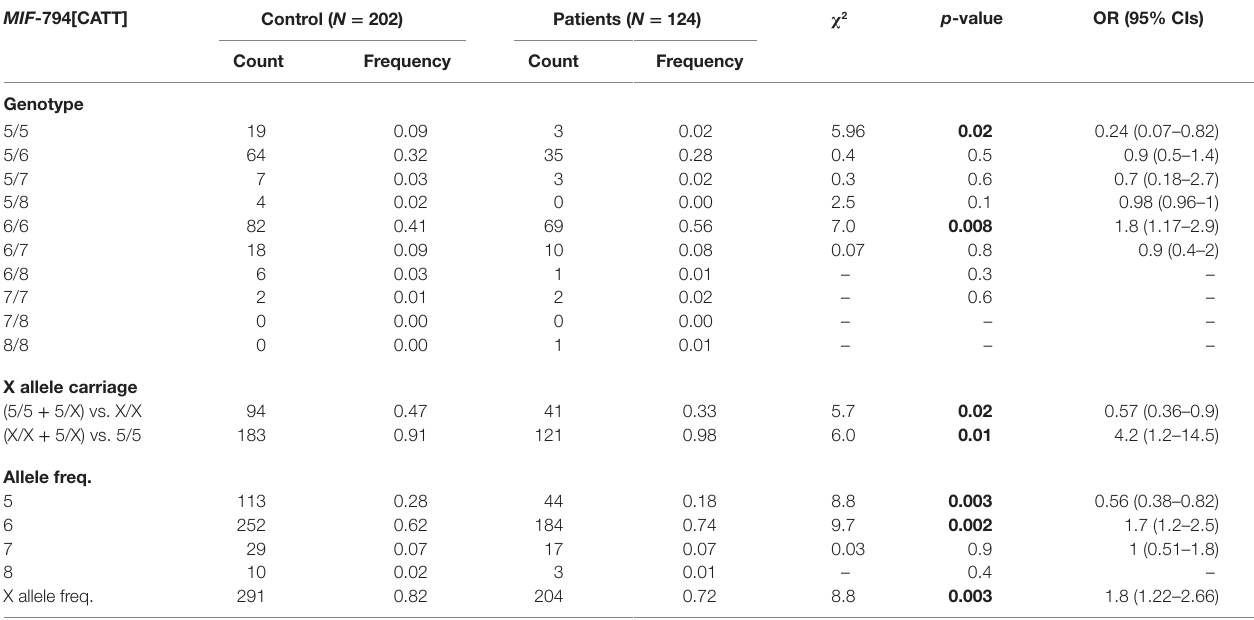
TaBle 3 | Distribution of MIF -794 repeat genotypes and allele frequencies in patients and controls. MIF